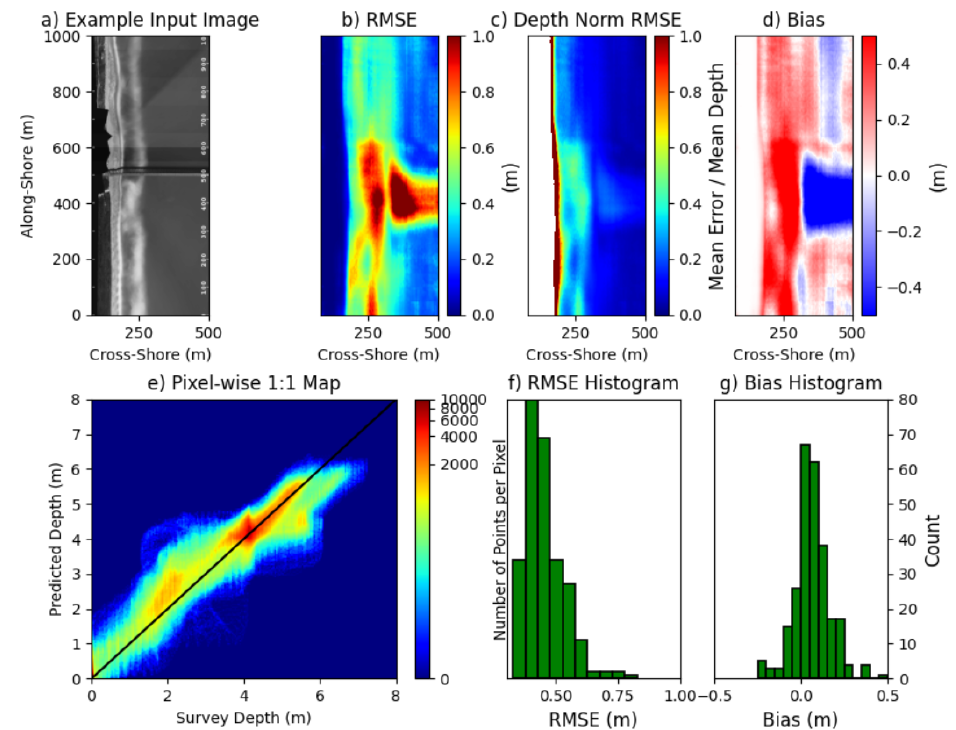
Figure 3. ( a ) Example input Timex image, ( b ) Spatial RMSE, ( c ) depth-normalized RMSE, and ( d ) bias are shown as a function of cross-shore (x-axis) and along-shore (y-axis) coordinates over the entire test set. ( e ) shows a 1:1 plot of the surveyed depth to predicted depth for each cell, colored by the number of occurrences for each depth pair. Histograms of image-wise RMSE and bias are shown in ( f , g ), respectively. The shoreline in this figure, and all following figures, is vertically oriented to the FRF coordinate system, with increased distance from shore being shown on the